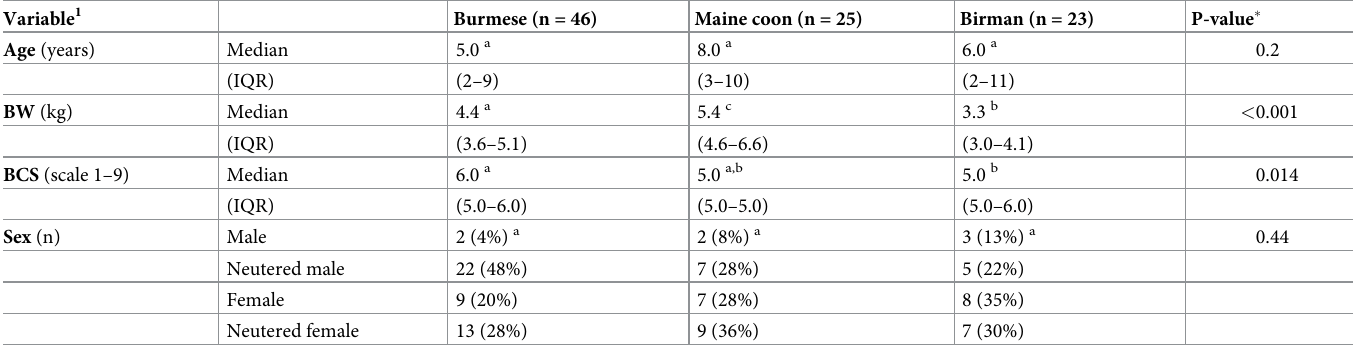
Table 1. Descriptive statistics of the included cats (n = 94) by